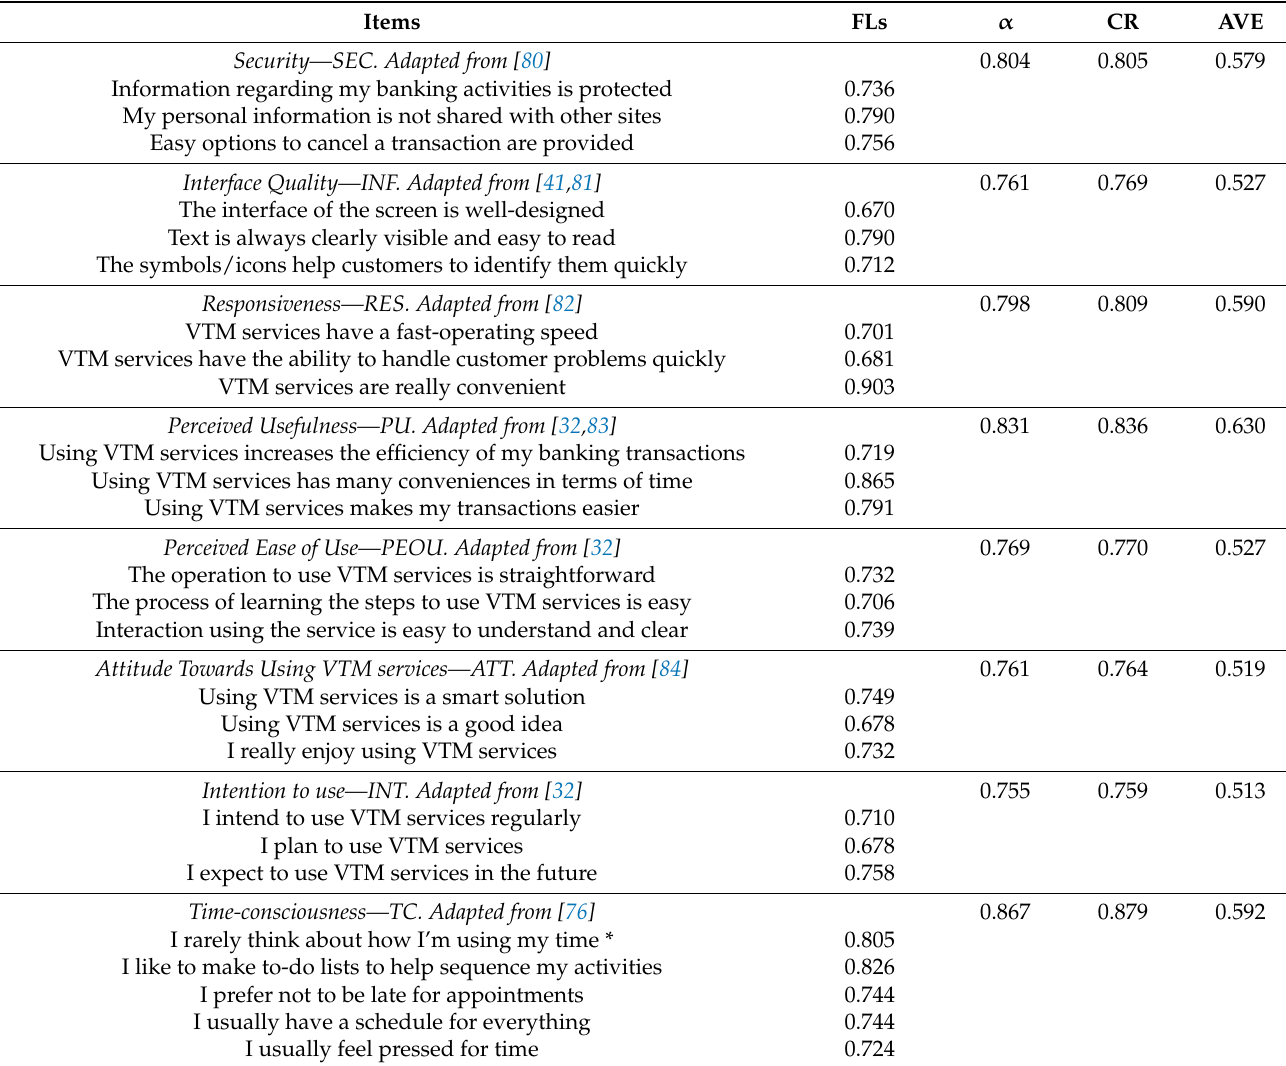
Table 2. Items, reliability, and convergent validity.